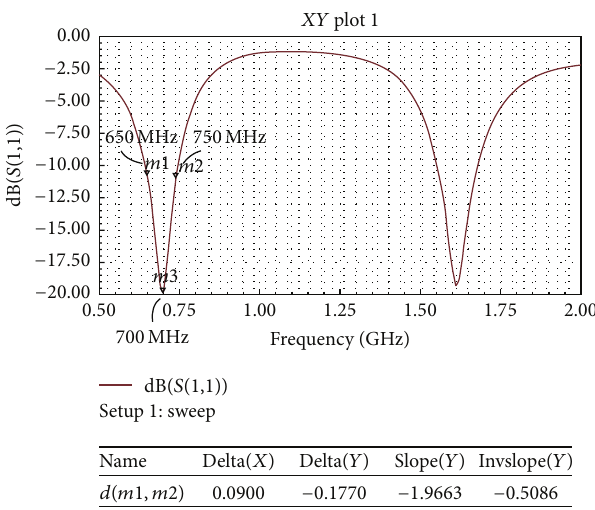
Figure 6: Magnitude versus frequency (simulation).